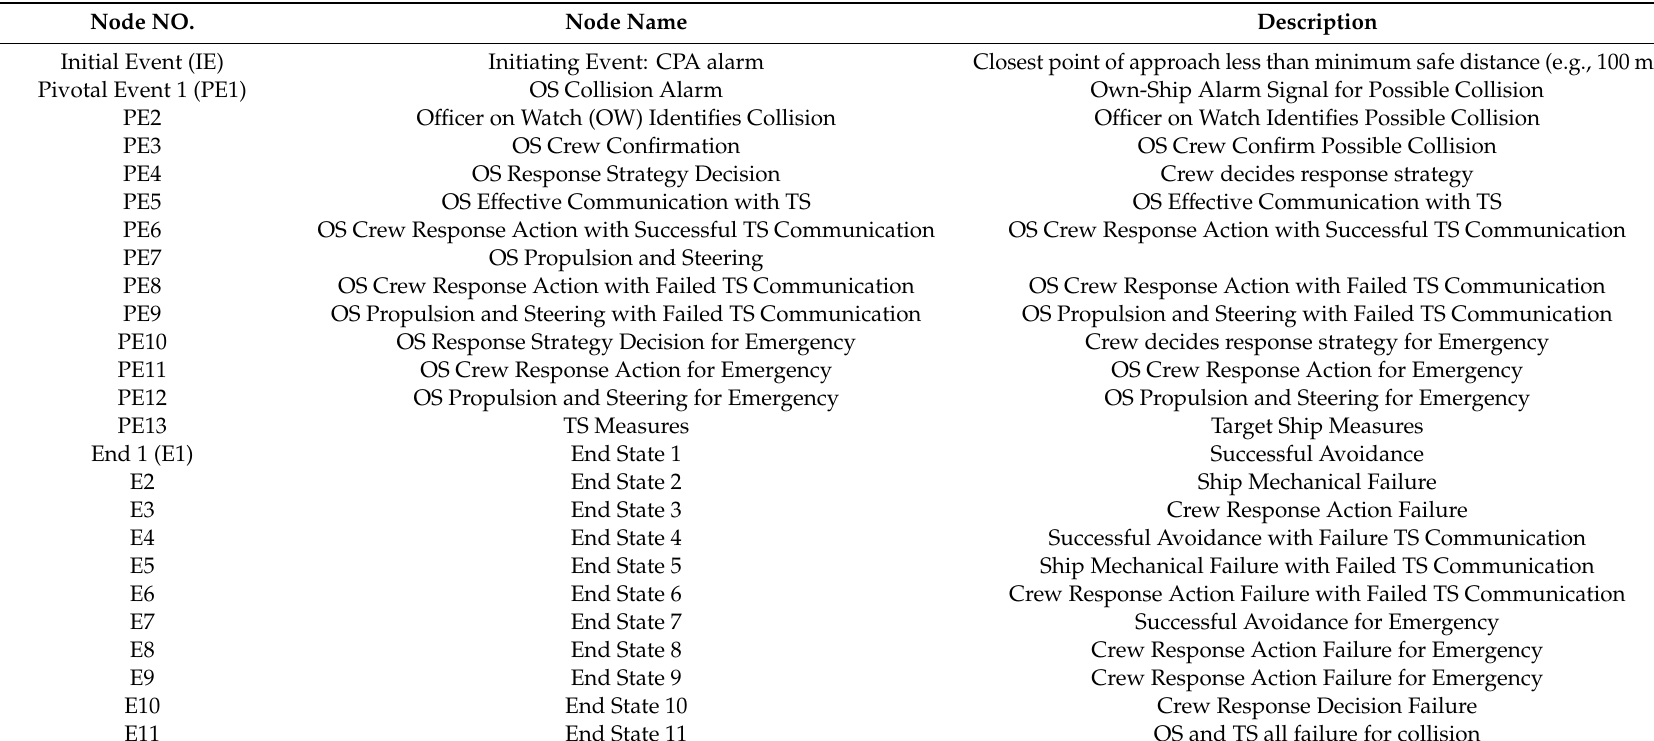
Table 1. Events’ information in ESD of Figure